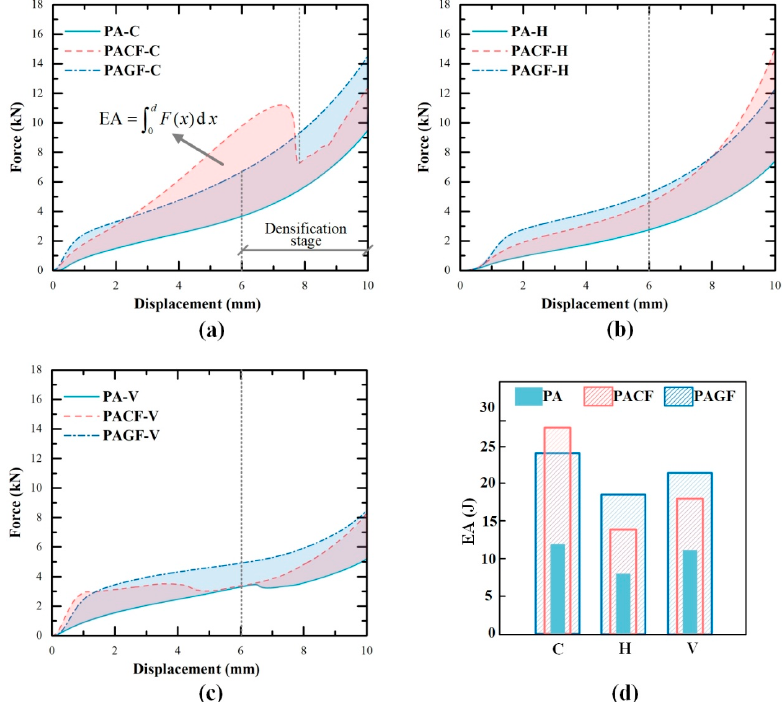
Figure 12. Force-displacement curves of different columns in different scanning strategies: ( a ) circular; ( b ) horizontal; ( c ) vertical; and ( d ) energy absorption capabilities of different columns.